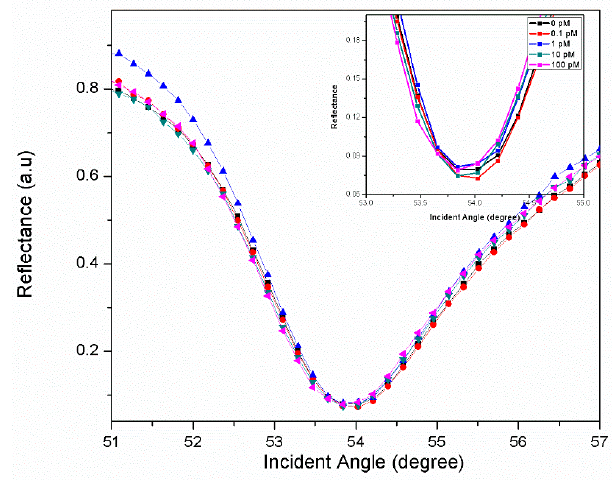
Figure 5. Optical reflectance for DENV concentrations (0.1–100 pM) in contact with Au/CdSQDs- rGO/Ab layer (inset: the zoomed in graph).